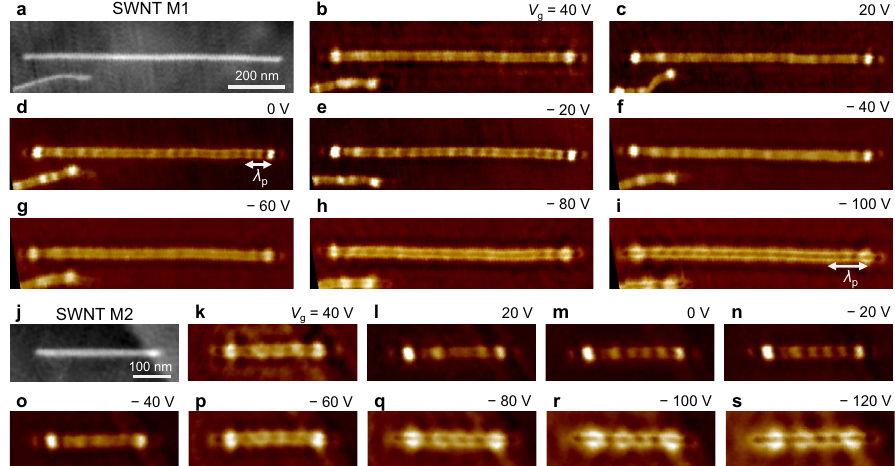
Fig. 2 Gate-tunable plasmons in a SWNT/h-BN/graphene heterostructure. a Topography of a long SWNT M1. b – i Corresponding near- fi eld images of SWNT M1 at various gate voltages from 40 to − 100 V. The twin fringes parallel with the nanotube arise from the interference between the tip-launched and nanotube-re fl ected graphene plasmon waves. As the gate voltage is increased, the twin fringes become more visible and separated. This evolution shows that the graphene carrier density and associated graphene plasmons are continuously tuned by the applied gate voltage. We clearly observe that prominent near- fi eld oscillations emerge near the right nanotube end and that they depend sensitively on the gate voltage. The plasmon wavelength λ equal to twice the oscillation period in the near- fi eld images, is marked by the white double arrow ( d and i ) and becomes longer as the gate voltage is varied further away from 0 V. j Topography of a short SWNT M2. k – s Corresponding near- fi eld images of SWNT M2 at various gate voltages from 40 to − 120 V. SWNT M2 acts as a Fabry – Perot plasmonic nanocavity where propagating plasmons are re fl ected back and forth by both ends and produce a collective response. From m – s , the number of antinodes decreases from 7 to 4. The achieved plasmon wavelength modulation is estimated to be